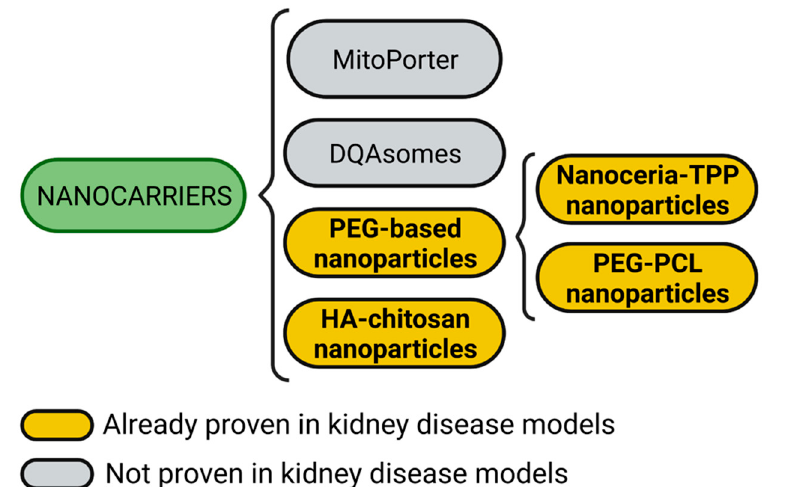
Figure 4. Mitochondria targeting nanocarriers. Nanocarrier systems targeting mitochondria include mitoPorter, DQAsomes, hyaluronic acid (HA)-chitosan nanoparticles, and polyethylene glycol (PEG)-based nanoparticles. PEG-based nanoparticles could also be subdivided into cerium oxide nanoparticles (nanoceria) harboring triphenylphosphonium (TPP) moieties and PEG-polycaprolactone (PCL) nanoparticles. Figure created with BioRender.com.